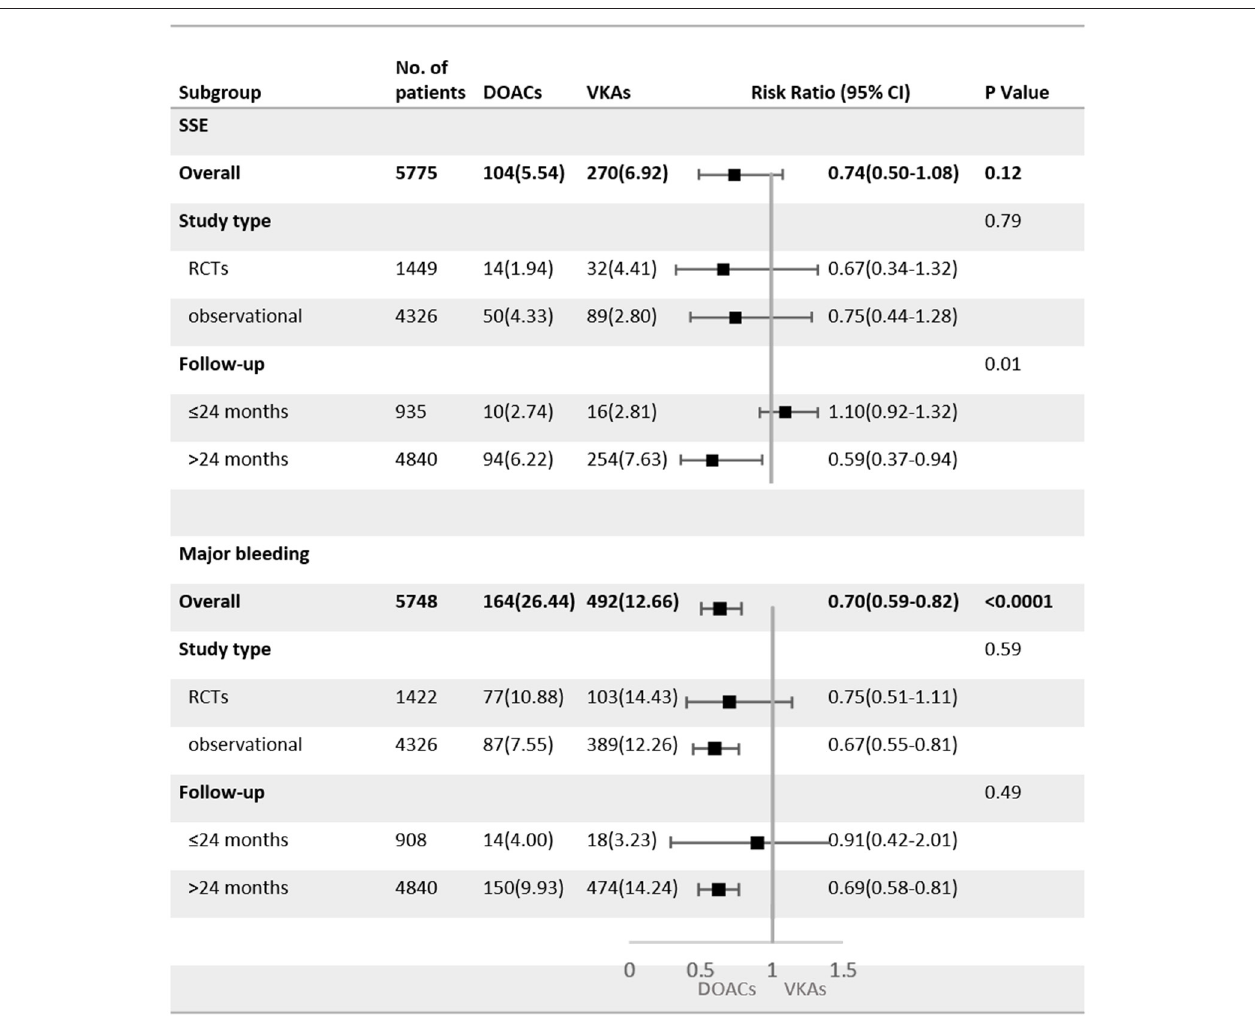
FIGURE 4 | Subgroup analysis of adjusted efficacy and safety data of DOACs compared with VKAs among AF patients with BPHV. SSE, Stroke or systemic embolism; RCTs, randomized controlled trials; DOACs, direct-acting oral anticoagulants; CI, confidence interval; VKAs, vitamin K